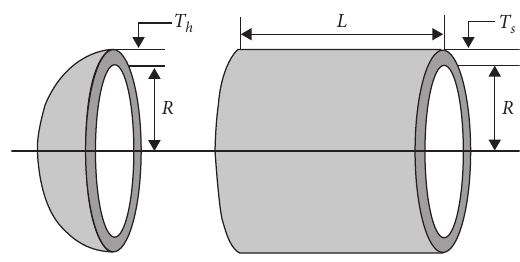
Figure 5: The model of pressure vessel design